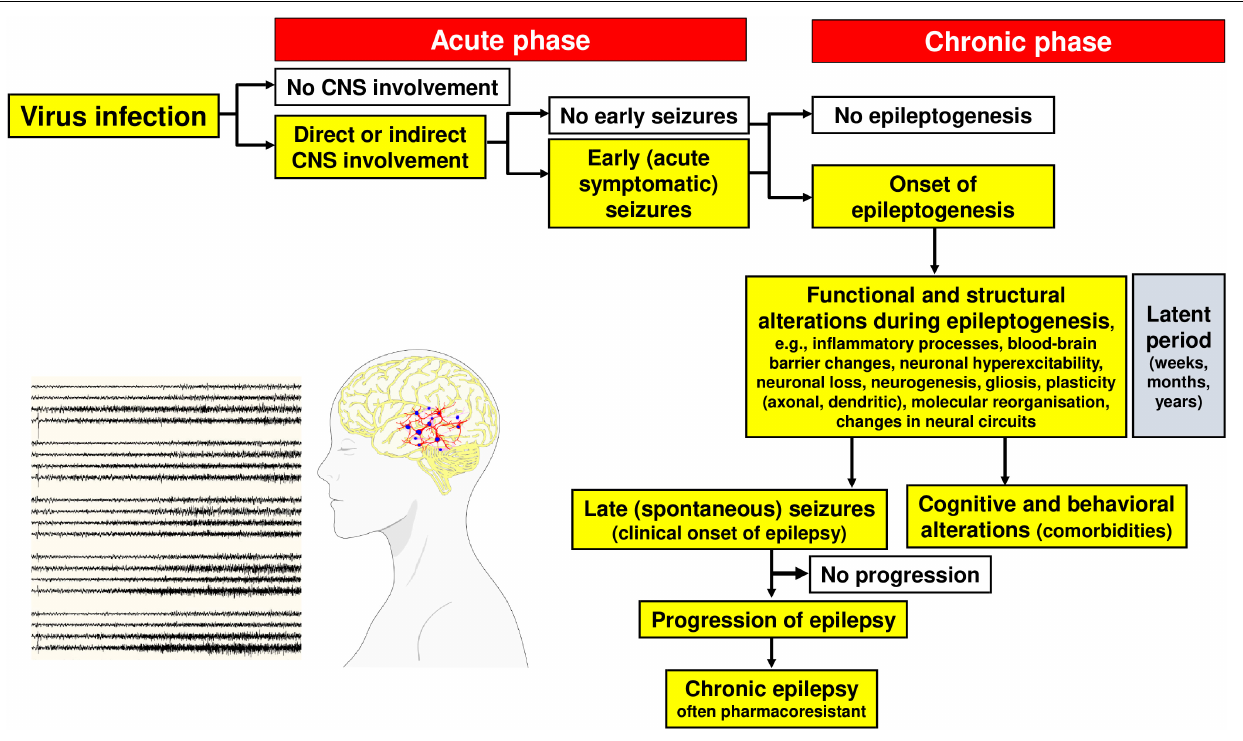
FIGURE 4 | Steps in the development and progression of acquired epilepsy (often temporal lobe epilepsy) as a consequence of viral infections. The term epileptogenesis includes processes that take place before the first spontaneous seizure occurs, which render the brain susceptible to spontaneous recurrent seizures and processes that intensify seizures and make them more refractory to therapy (progression). The concept illustrated in the figure is based on both experimental and clinical data. Adapted from Löscher et al.